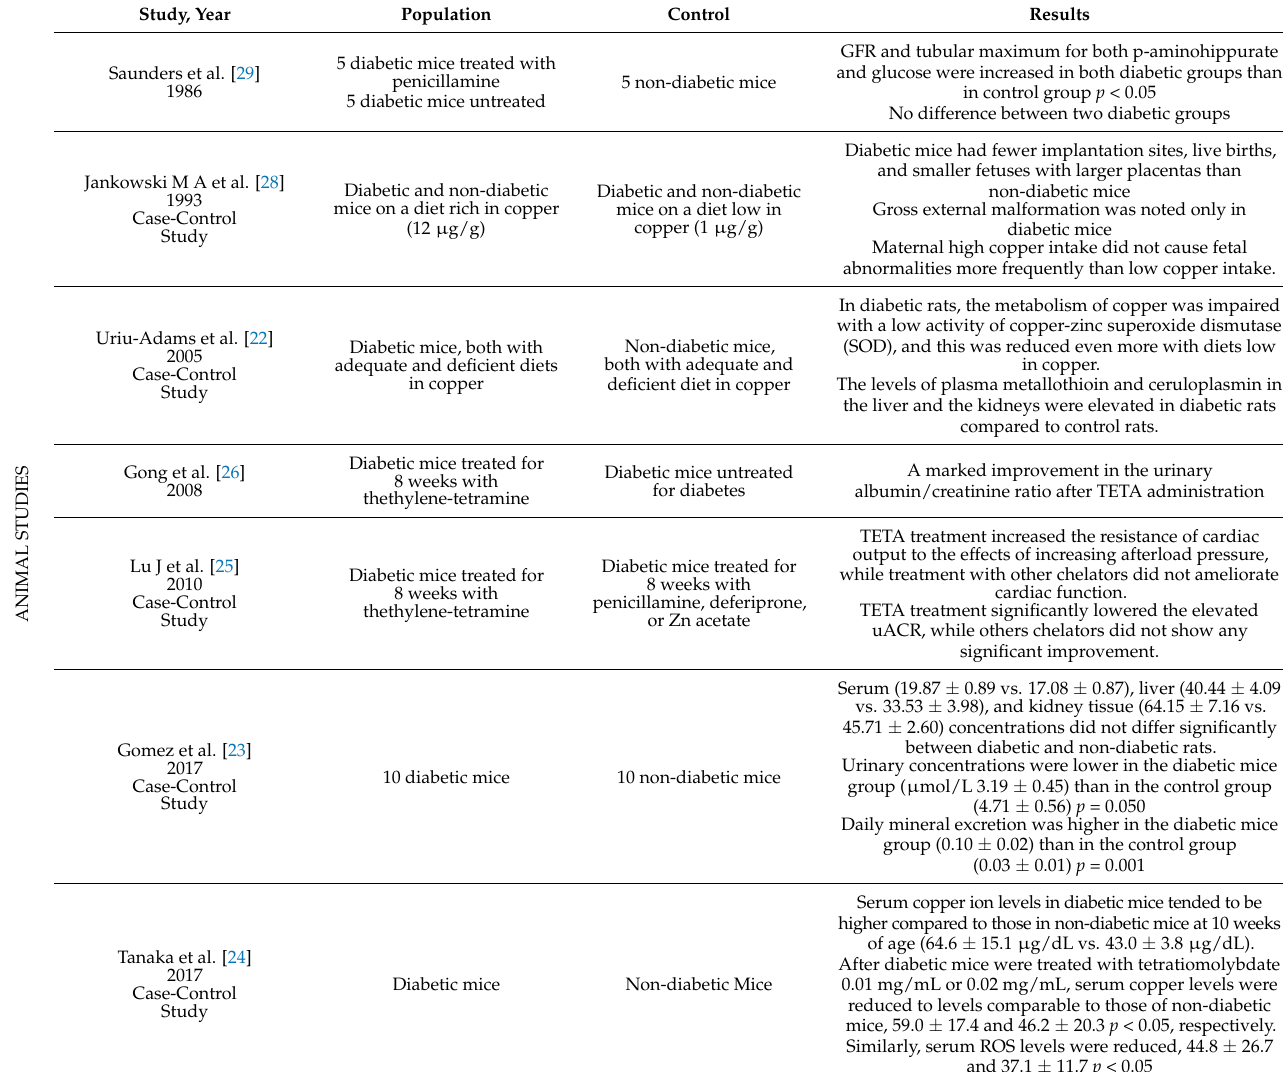
Table 2. GFR, Glomerular Filtration Rate. SOD, Superoxide Dismutase. T2DM Type 2